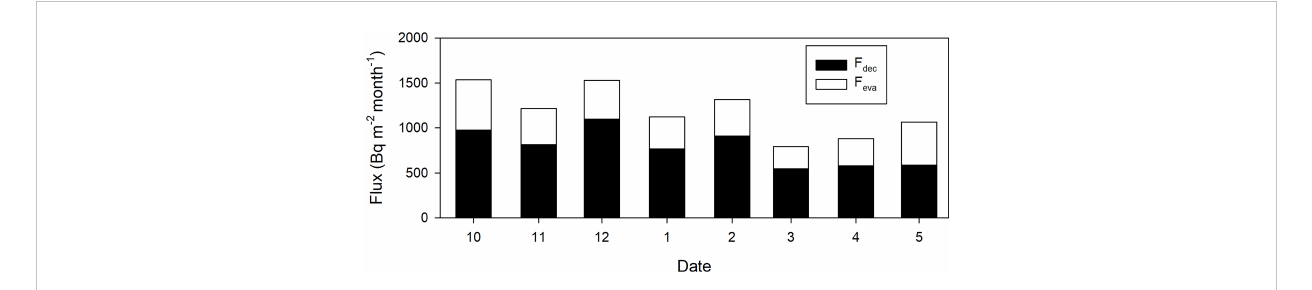
FIGURE 4 Histogram showing monthly-integrated 222 Rn fl uxes through evasion and